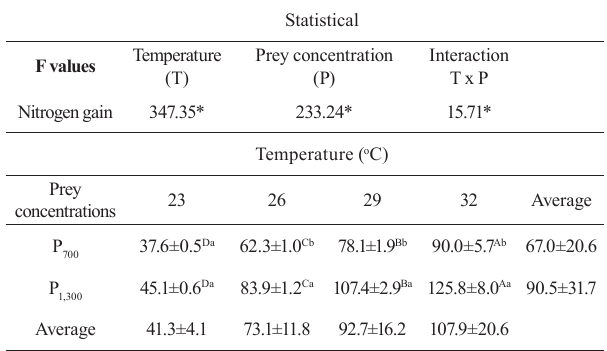
Table 3 . Nitrogen gain (mg mg -1 day -1 ) after 15 days of exogenous feeding of Lophiosilurus alexandri . F values and means ± standard deviation ( P <0.05). Means followed by the same letters (a, b, on the columns and A, B, C, D on the lines) did not differ by Tukey’s test ( P <0.05). * P